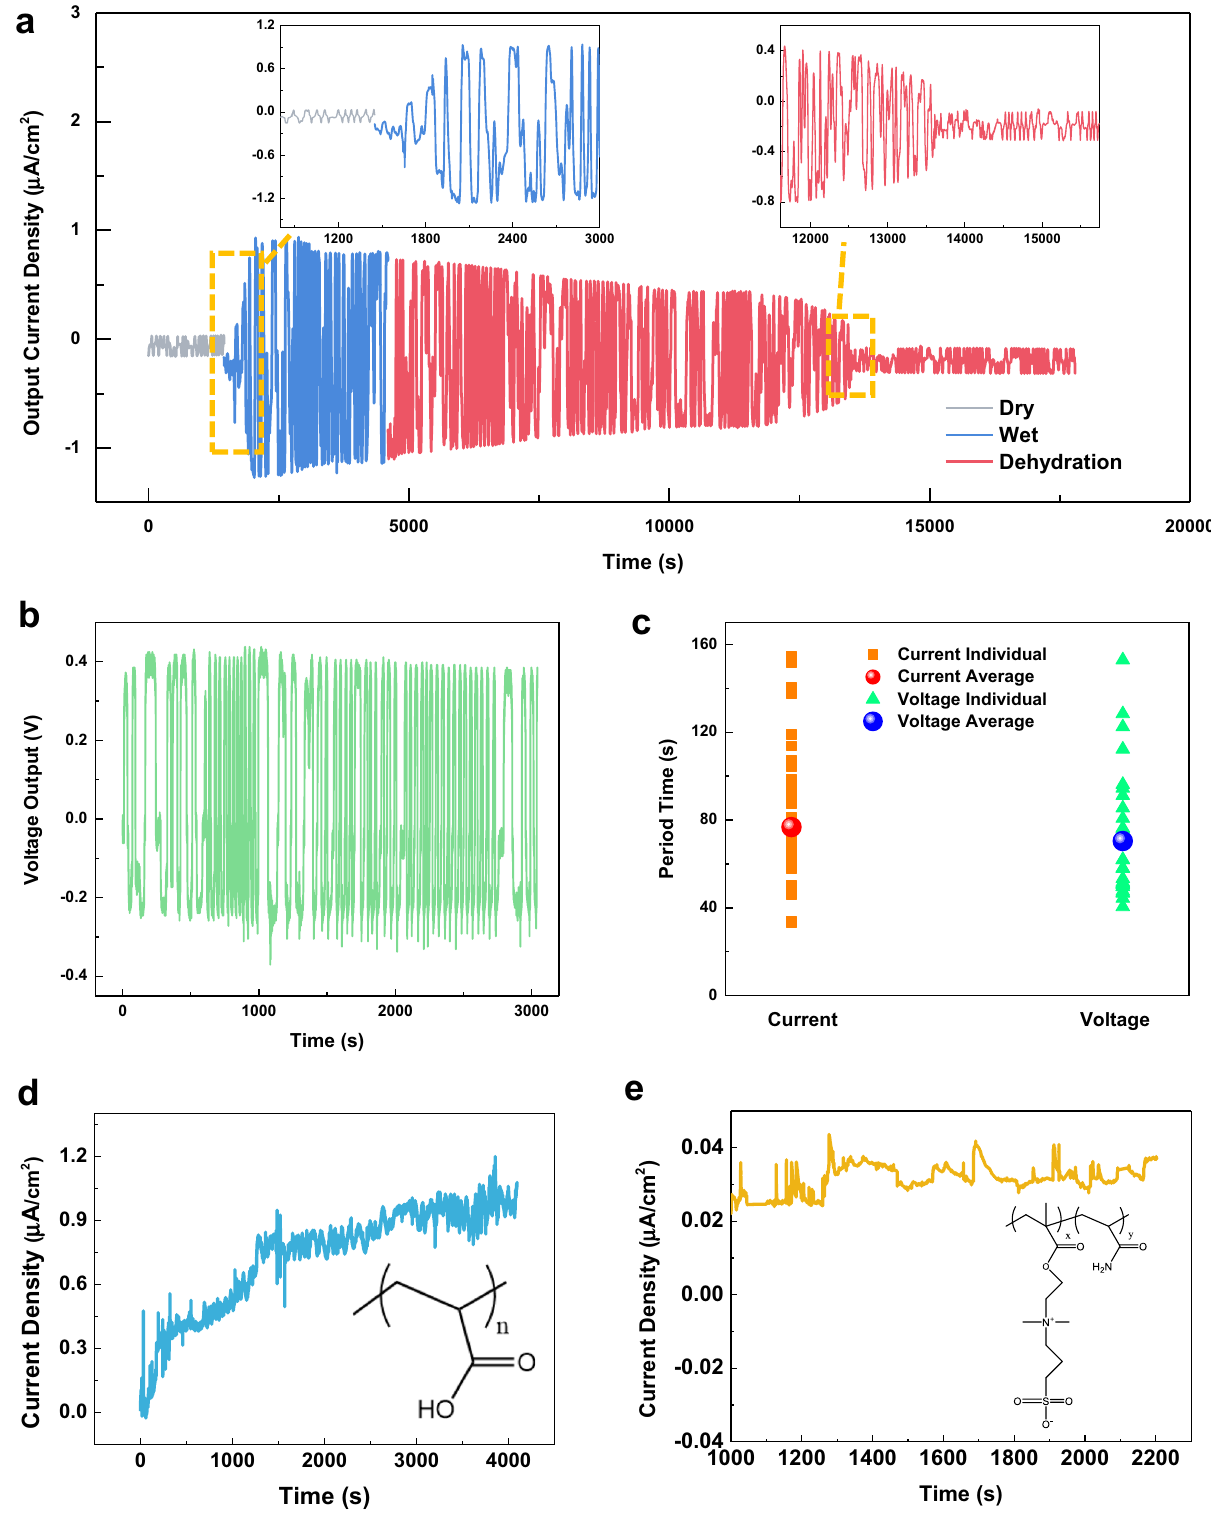
Fig. 3 Performances of a prototype energy harvester based on surface potential oscillations. a Short-circuit current density versus time of a prototype energy harvester before the introduction of the moisture (gray color), after the moisture wetting process by a humidi fi er (blue color), and the dehydration process by removing the humidi fi er (red color). Insets show enlarged views for the wetting (upper left) and dehydration (upper right) processes. b The open-circuit voltage versus time in the moisture wetting process by a humidi fi er. c The testing results of the working cycle period of the open-circuit voltage and short-circuit current. d An example of replacing [2-(methacryloyloxy)ethyl] dimethyl-(3-sulfopropyl) ammonium hydroxide (MEDSAH) monomer with poly(acrylic acid) (PAA) to remove the SO 3 − and N + groups in the polymer, which stops the autonomous oscillations to result in DC electrical outputs. e In another example, the acrylic acid (AA) monomer is replaced with acrylamide to remove the – COOH groups, and only DC outputs are also